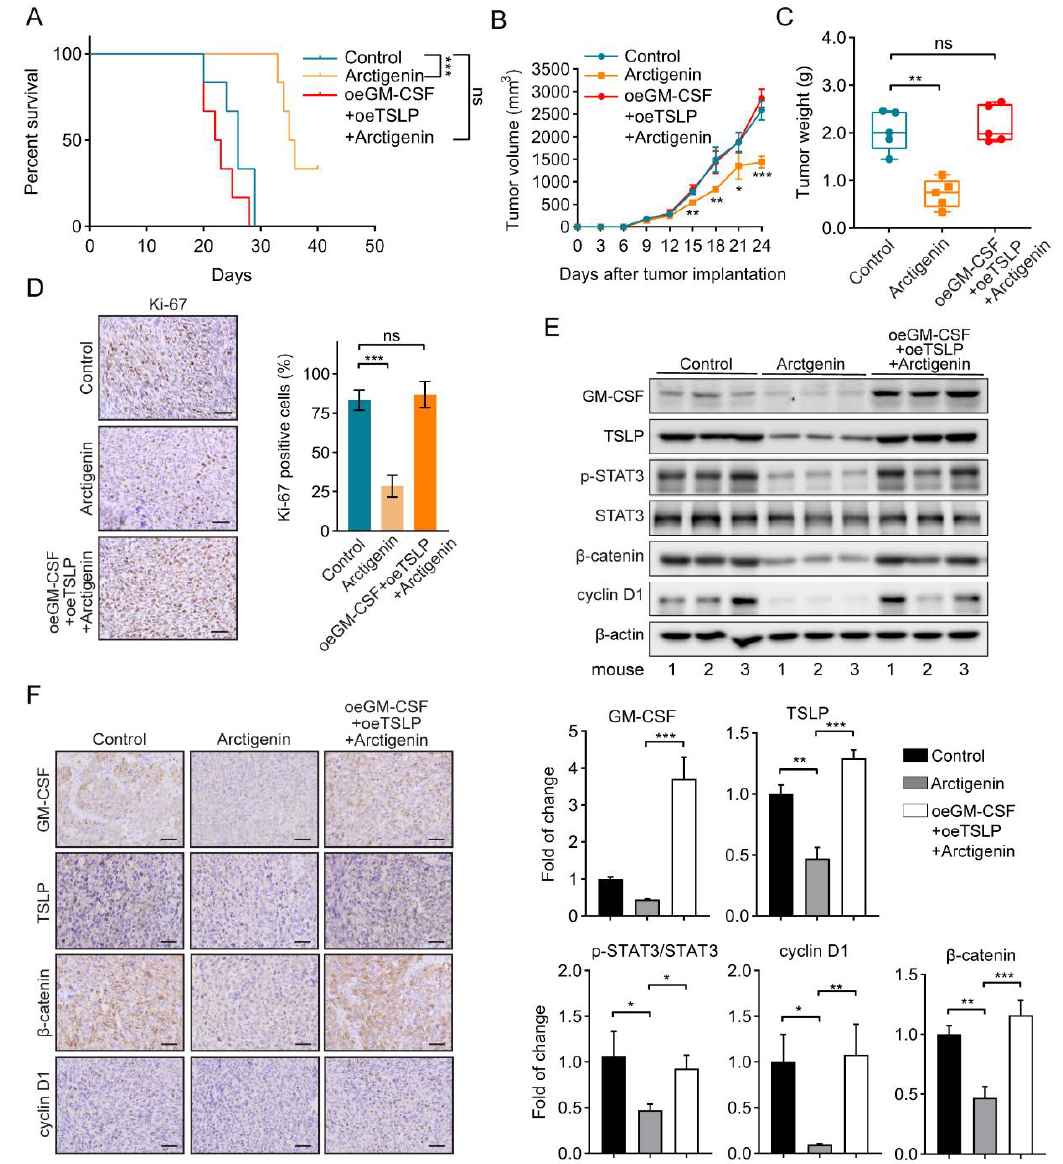
Figure 6. Arctigenin inhibits breast cancer progression via decreasing GM-CSF and TSLP in vivo. ( A ) Kaplan–Meier survival curves for mice injected with the indicated 4T1 cells and / or treated with arctigenin. oe, overexpression. n = 6 mice/group. *** p < 0.01, ns, not significant, p > 0.05 (Log Rank test). ( B ) The tumor volume of 4T1 tumors separated from mice of each group. ( C ) The tumor weight of separated 4T1 tumors in each group. ( D ) Representative Ki-67 staining (left panel) and statistics (right panel) of 4T1 tumors from the indicated mice. Scale bar, 100 μm. ( E ) The levels of GM-CSF, TSLP, p-STAT3, STAT3, β-catenin and cyclin D1 of the indicated tumors from representative mice were analyzed by Western blotting analysis. Mouse number was indicated at bottom. ( F ) Representative immunohistological staining of GM-CSF, TSLP, β-catenin and cyclin D1 in the indicated tumor sections. Scale bar, 100 μm. For ( B )–( D ) (right panel) and ( E ), the data are shown as mean ± SD. Statistically significant differences are indicated: * p < 0.05, ** p < 0.01, *** p < 0.001, ns, not significant, and p > 0.05 (One-way ANOVA).